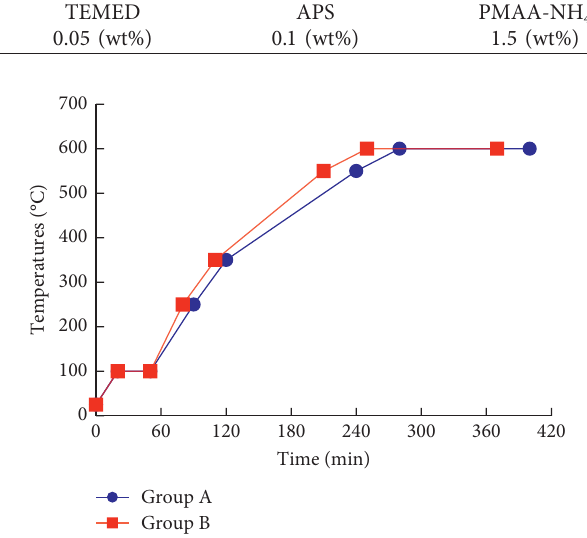
Figure 1: Presintering heating curve of samples of group A and group B.